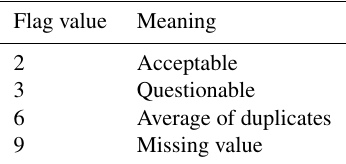
Table 4. World Ocean Circulation Experiment (WOCE) World Hy- drographic Program (WHP) (Joyce and Corry, 1994; Swift and Diggs, 2008) QC flags used for this